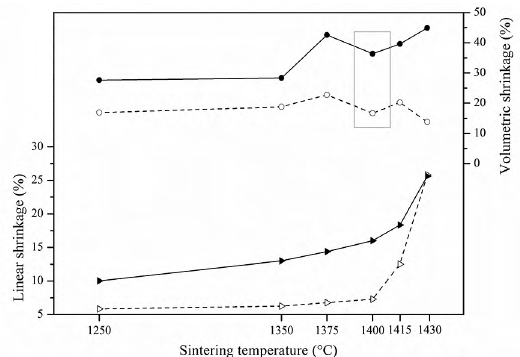
Figure 4. Evolution of linear and volumetric shrinkage of pressed (dashed line) and injection molded (solid line) samples according to the sintering temperature. The grey square marker indicates the temperature at which swelling occurred.